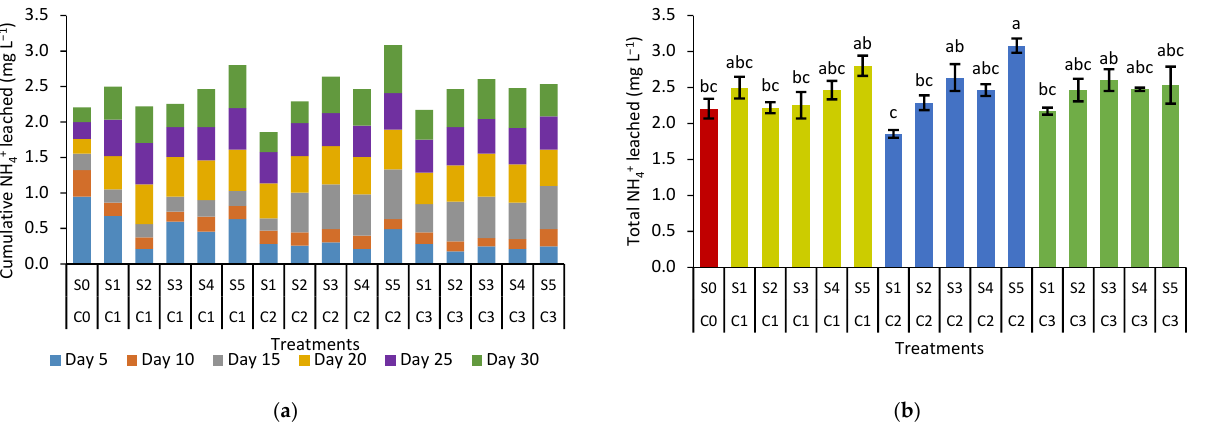
Figure 3. ( a ) Cumulative ammonium in leachates at five day intervals and ( b ) total ammonium in leachates for the different treatments after thirty days of leaching. Different letters indicate significant mean differences using Tukey’s HSD test at p ≤ 0.05. Error bars represent the standard error of the mean.